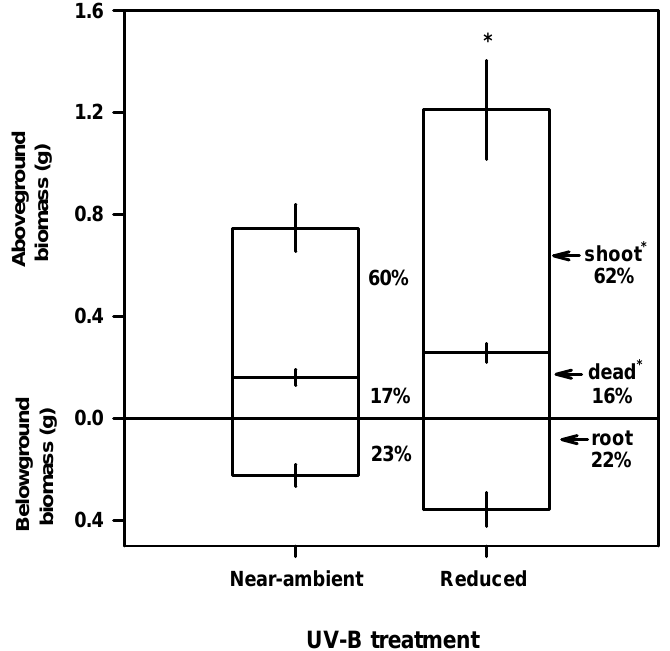
Figure 1. Effects of UV-B reduction on aboveground and belowground biomass of A. sativa under UV-B treatment frames after 52 d. Values are means of individual plants (n=10). Vertical bars represent +1 SE and * indicates a significant UV-B treatment effect ( P ≤